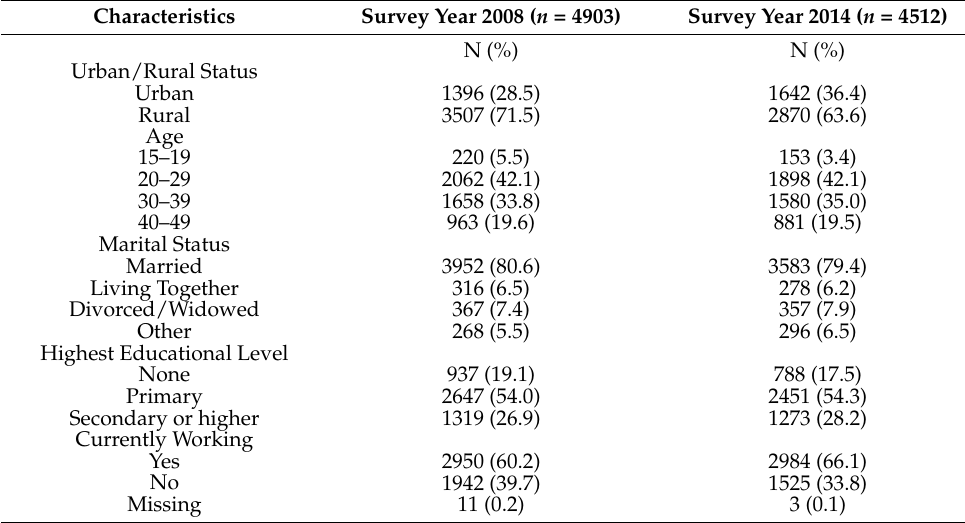
Table 1. Demographic Characteristics of Study Population.